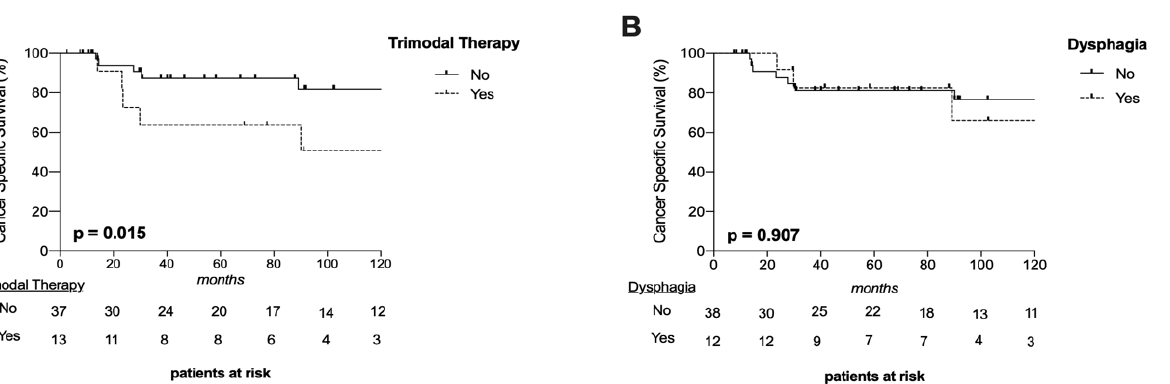
Table 4. Impact of radiation-associated side-effects and PAS score on follow-up dysphagia.